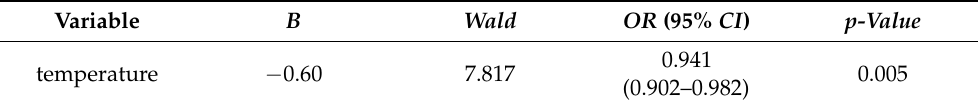
Table 2. Logistic regression analysis of the effect of temperature on S. caerulea ’s female ratio. Variable B Wald temperature